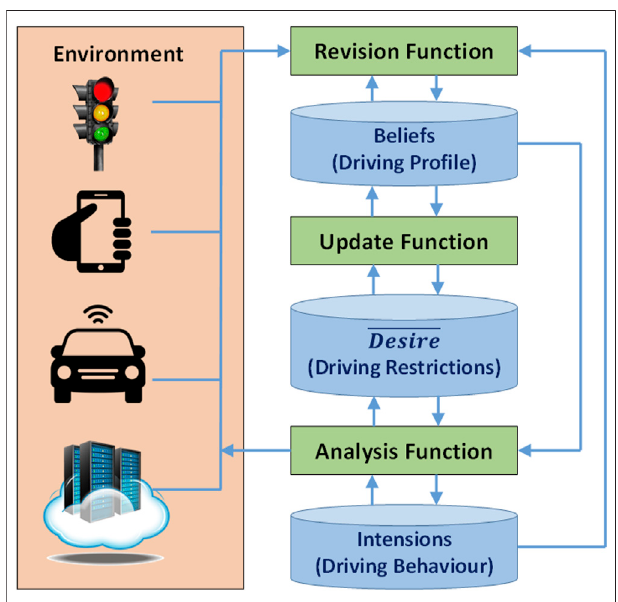
FIGURE 4 | Proposed BDI